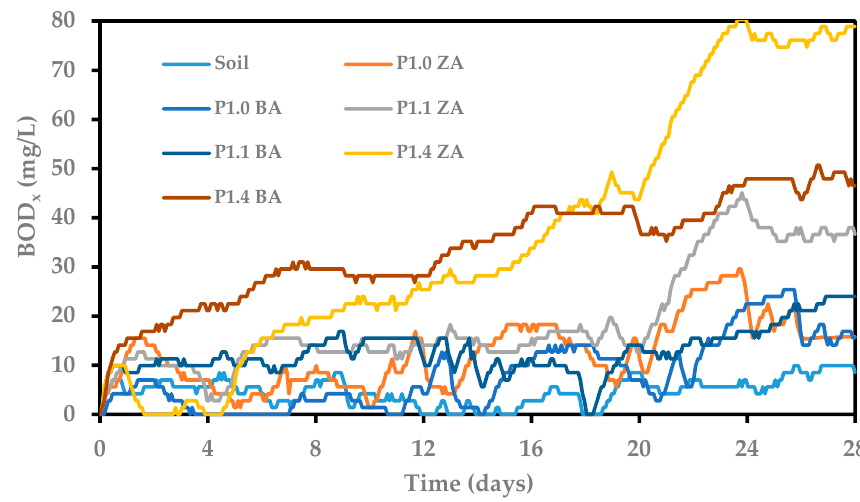
Figure 11. Results of biochemical oxygen demand of RPU / PIR foams during 28 days in soil.